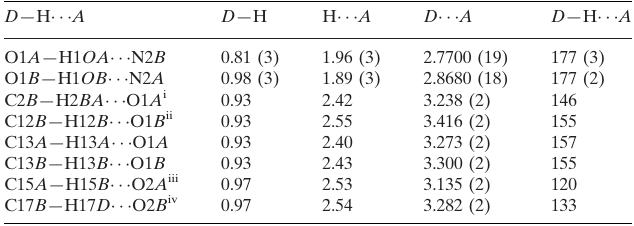
Hydrogen-bond geometry (A˚ , (cid:2)